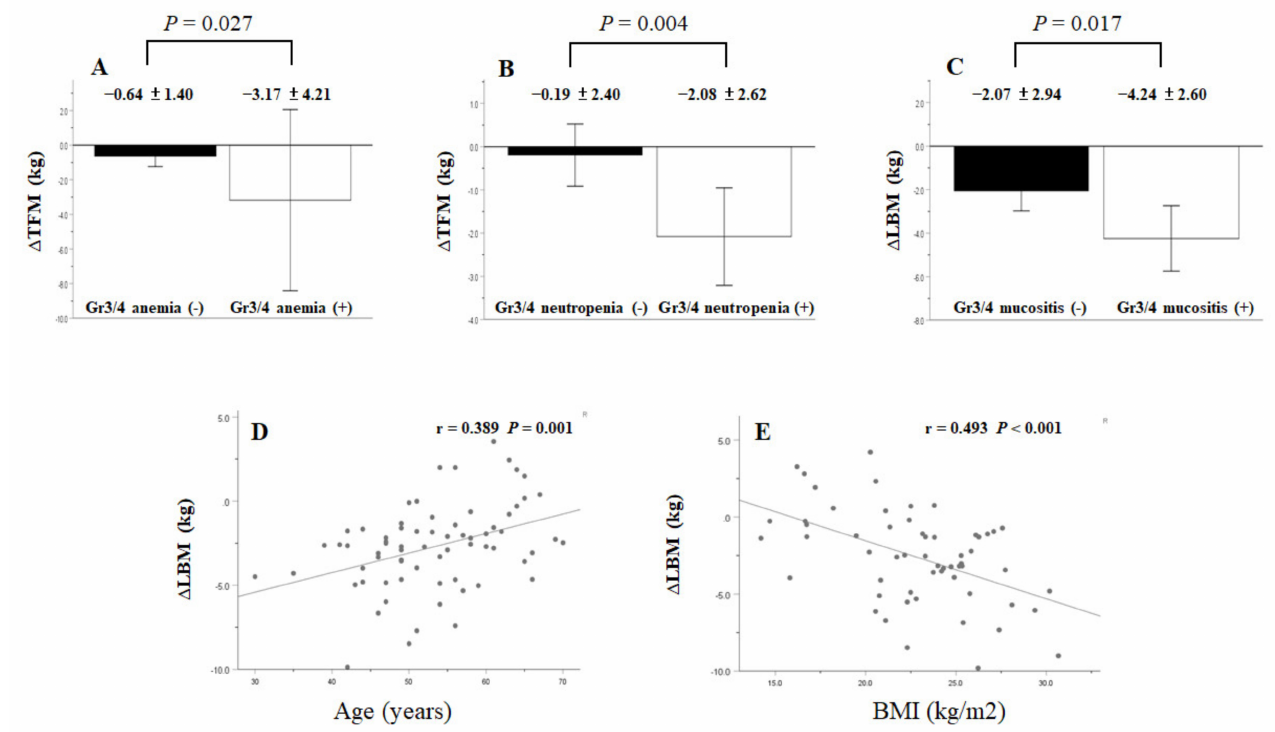
Figure 4. Oral cavity cancer patients with grade 3 / 4 toxicity of anemia or neutropenia developed more TFM loss ( A , B ). Non-oral cavity cancer patients with grade 3 / 4 mucositis toxicity developed more LBM loss ( C ). The association of age with ∆ LBM in oral cavity cancer patients or BMI with ∆ LBM in non-oral cavity cancer patients ( D , E ). ∆ indicates a value obtained by subtracting the pre-CCRT value from the post-CCRT value. LBM, lean body mass; TFM, total fat mass; CCRT, concurrent chemoradiotherapy; BMI, body mass